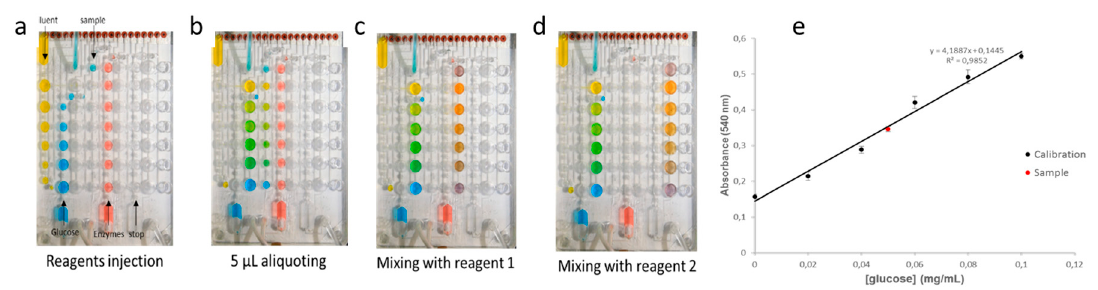
Figure 3. Validation of glucose assay with on chip calibration curve: Protocol steps ( a – d ). Plots of absorbance intensities at 540 nm depending on the dilution factors ( e